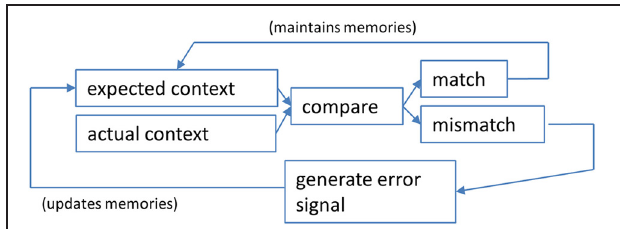
FIGURE 1 | A schematic illustration of the steps involved in a context prediction error analysis. Information about expected features of a given context are compared against actual contextual features experienced by the animal. If they are perceived to be the same, a “match” signal is generated that maintains (or possibly strengthens) the neural network that underlies the current active memory. Pattern completion computations may predominate in such a determination of a match (see text for discussion). If a “mismatch” is detected, the result is hippocampal output that reflects the error in prediction. In this case, pattern separation computations may prevail over pattern completion computations. The impact of a context prediction error signal is to ultimately update long-term memories that will define the expected contextual features the next time an animal enters the same